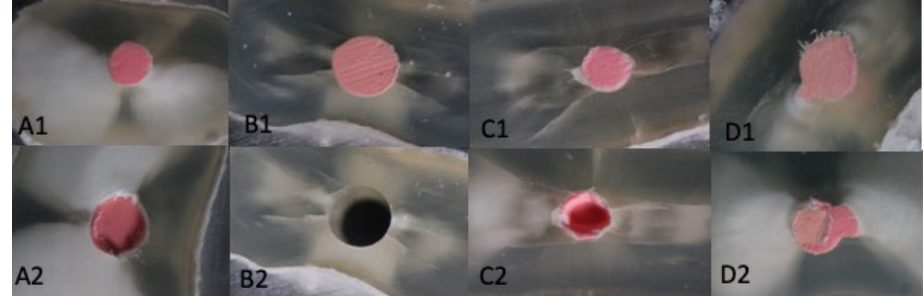
Figure 5. Initial situation ( A1 – D1 ), Gutta-percha/sealer interface failure- E2-BC ( A2 ), Dentin/sealer interface failure E1-DCR ( B2 ), Core material failure—gutta-percha ( C2 )-Real Seal, ( D2 )-Total Fill BC).